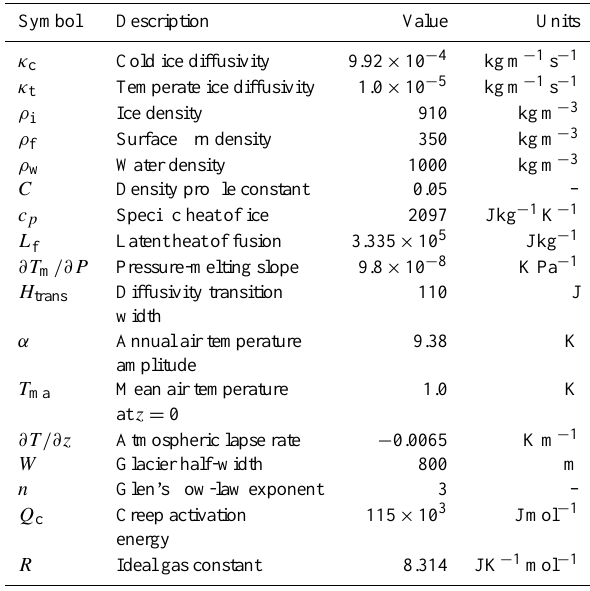
Table 1. Physical constants and model